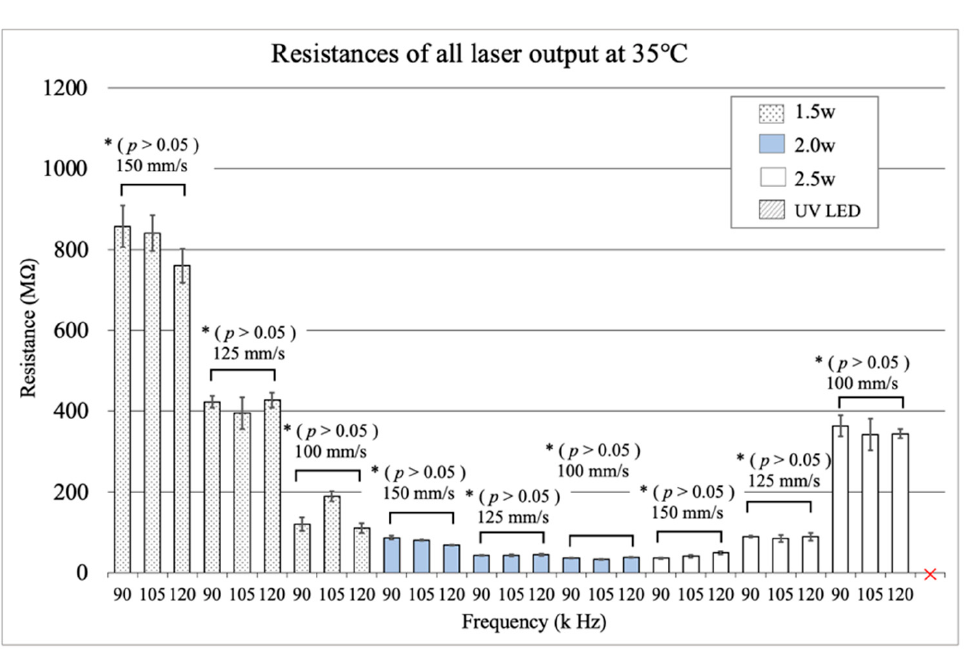
Figure 7. Resistance experimental results of all laser parameters that were measured at 100 ° C and compared with furnace calcination process (far right in each chart).